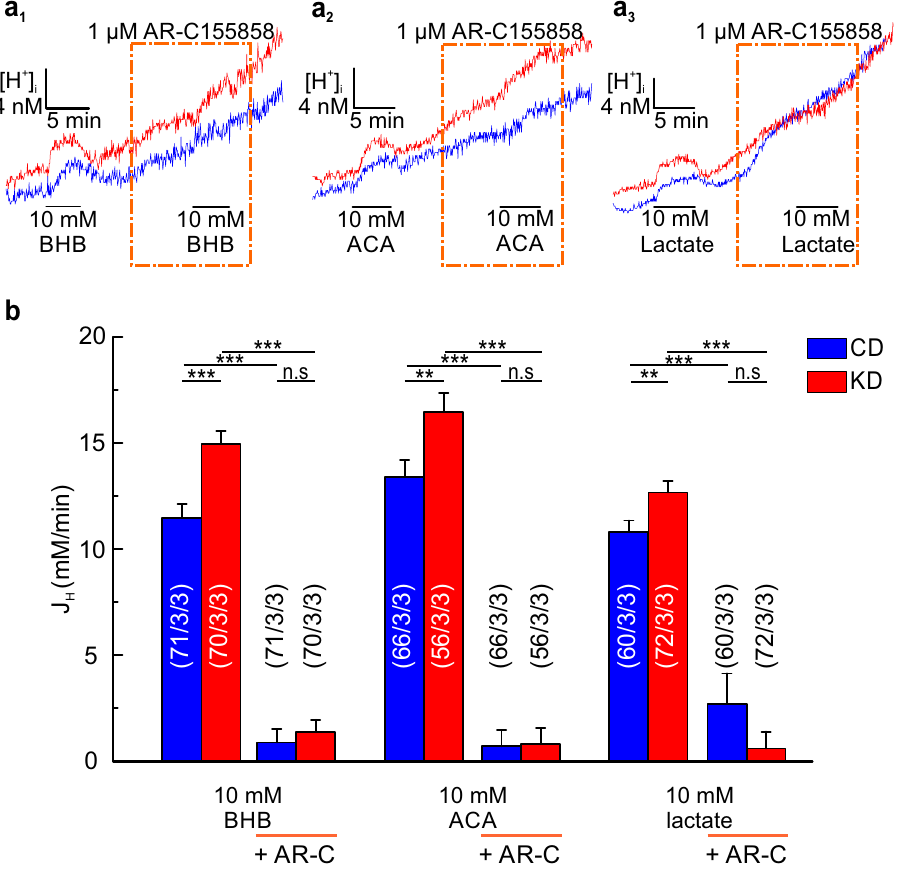
Figure 5. Enhanced transport activity under ketogenic conditions is mediated by MCT1. Original recordings of the change in [H + ] i , as induced by application of ( a 1 ) 10 mM BHB, ( a 2 ) 10 mM ACA, and ( a 3 ) 10 mM lactate in cortical astrocytes from mice fed with control diet (CD, blue traces) and ketogenic diet (KD, red traces) in 5% CO 2 /26 mM HCO 3 − -buffer in the absence and in the presence of 1 µ M of AR-C155858 (dashed orange boxes). ( b ) J H , as induced by 10 mM of BHB, ACA and lactate in CO 2 /HCO 3 − -buffered solution in astrocytes from CD (blue bars) and KD (red bars) in the absence and in the presence of AR-C155858. Statistical values are presented as means ± S.E.M and significance was tested with a paired Student’s t-test. Number of astrocytes/slices/mice are indicated in the bar